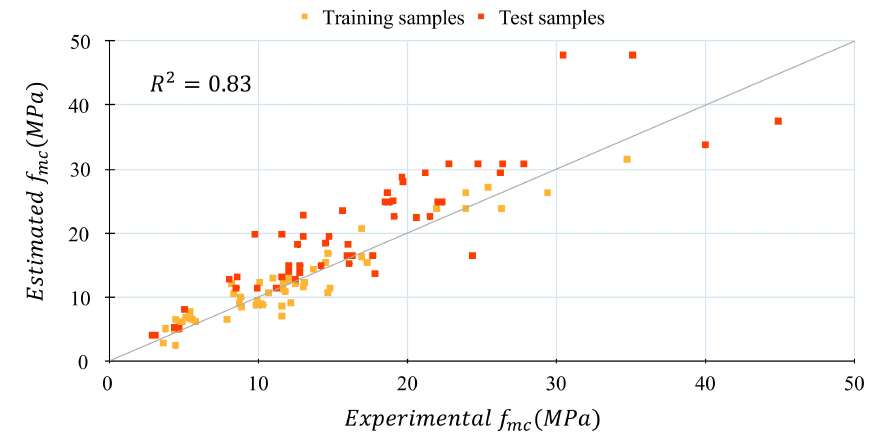
Figure 7. Comparison between complex symbolic regression model and experimental